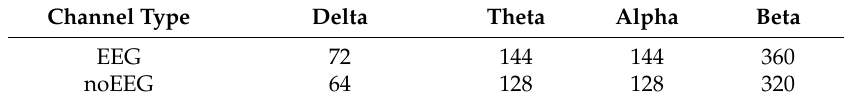
Table 2. The number of training and testing features for each frequency band and channel type.